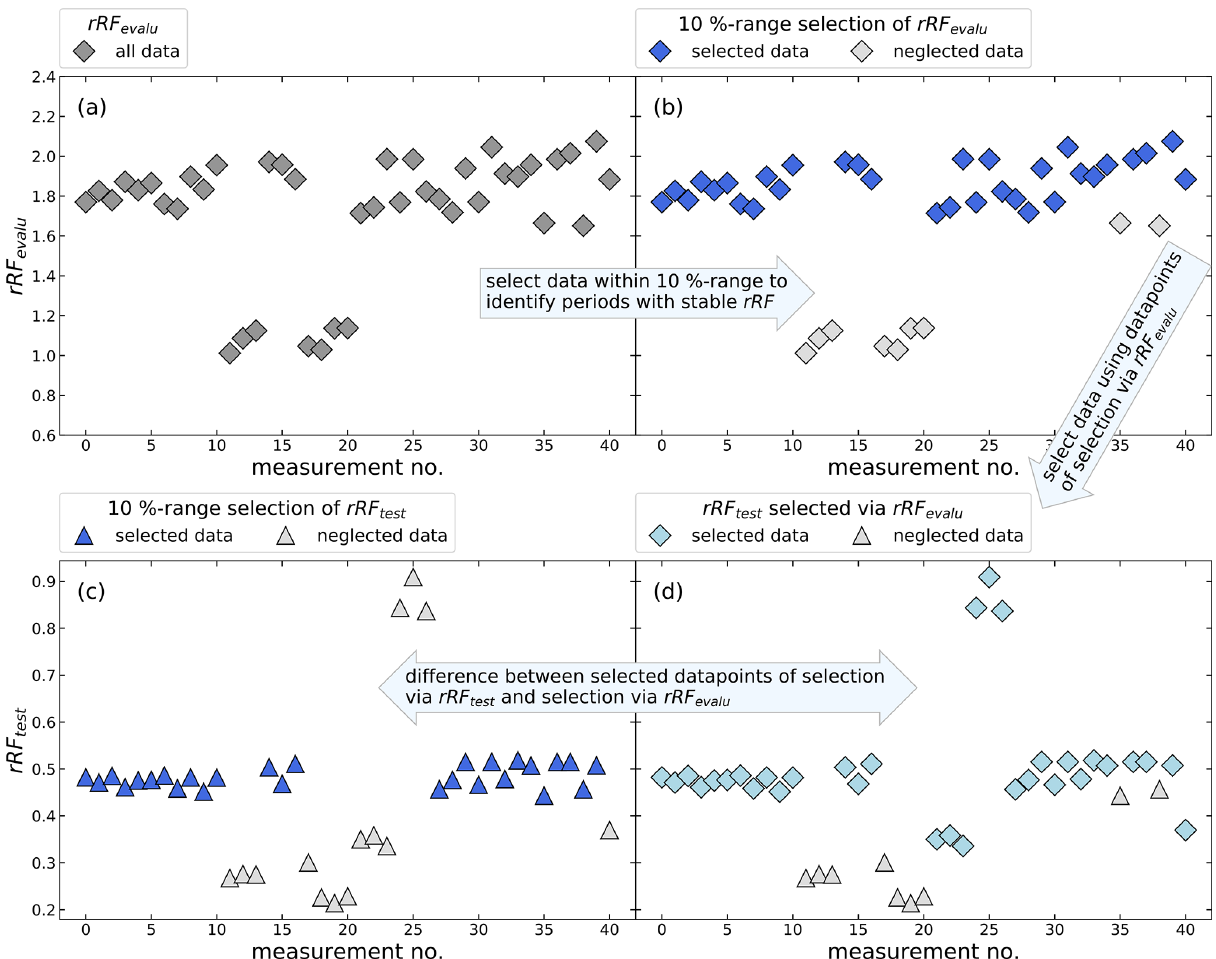
Figure 1. Schematic example using a random dataset of the identification of periods with constant rRF for an undetectable substance in the calibration standard. Panels (a) and (b) show the calculated rRF evalu of a known main reference and a known evaluation substance. Panel (b) shows which measurements will be selected, excluding measurements where the rRF differs more than 10%. The resulting selection of measurements should represent the periods of stable rRF test in panel (c) and (d) , where the rRF is determined using the main reference substance and an arbitrary test substance. The aim is to find a main reference and an evaluation substance, which have many measurements with a constant rRF and which will represent the selection of test substances as well as